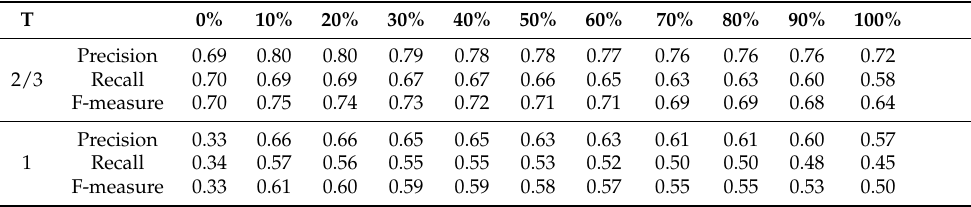
Table 8. Scene 2: Precision, recall, and F-measure values for groups detected by